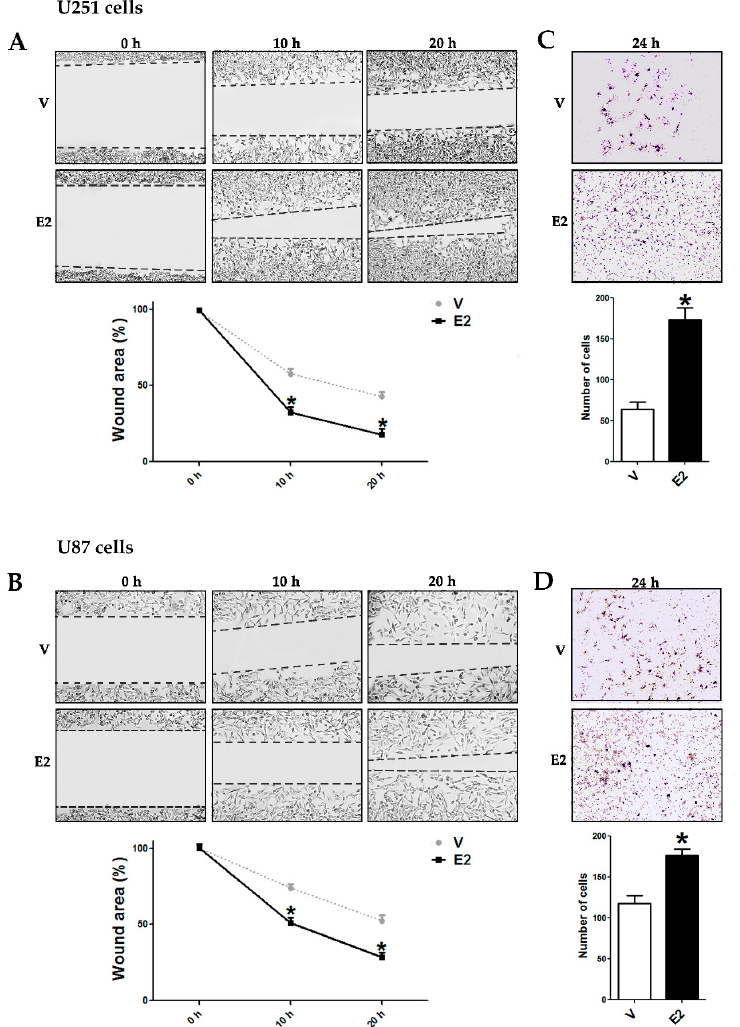
Figure 6. E2 increased migration and invasion of human GBM-derived cells. ( A , B ) Wound healing assays were performed in U251 and U87 cells treated with 17 β -estradiol (E2, 10 nM) and vehicle (V, cyclodextrin 0.01%). Representative images of wound closure at 0, 10, and 20 h and quantification of the wound area are shown. ( C , D ) Transwell assays were carried out in both cell lines. Quantification of cells staining with 0.1% crystal violet dye shows the number of invasive cells. Results are expressed as the mean ± standard error of the mean (SEM); n = 3; * p < 0.05 vs. V.